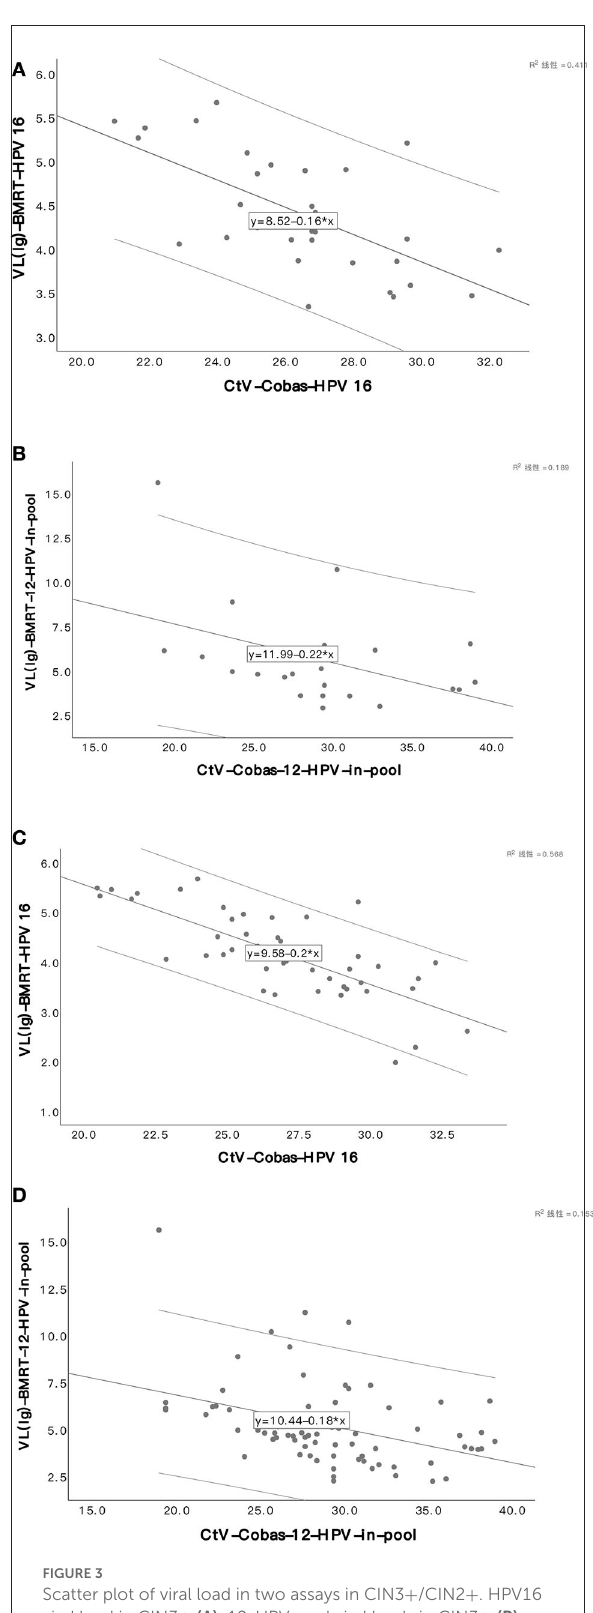
FIGURE3 Scatter plot of viral load in two assays in CIN3 + /CIN2 + . HPV16 viral load in CIN3 + (A) . 12-HPV pool viral loads in CIN3 + (B) . HPV16 viral load in CIN2 + (C) . 12-HPV pool viral loads in CIN2 + (D)